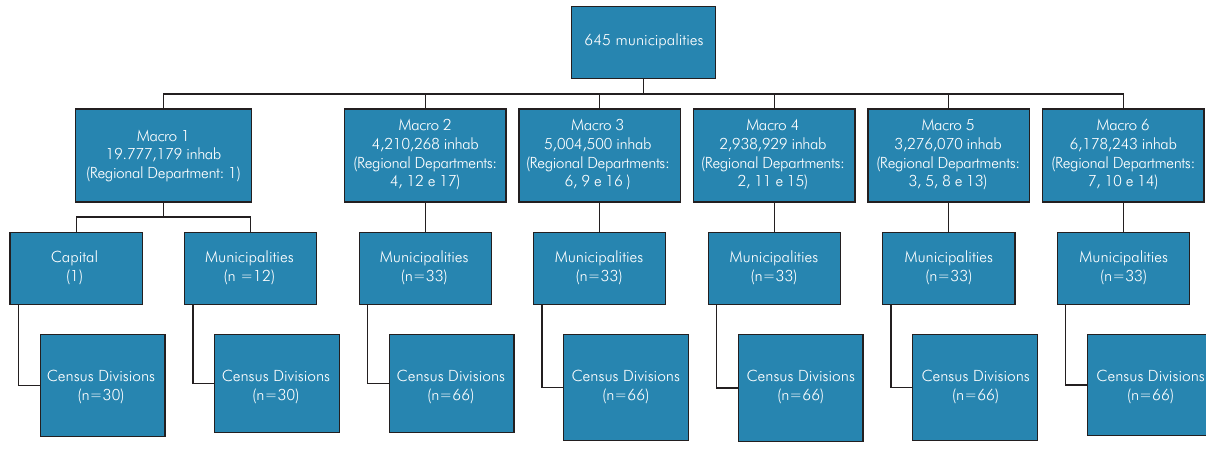
Figure 1. Sample design